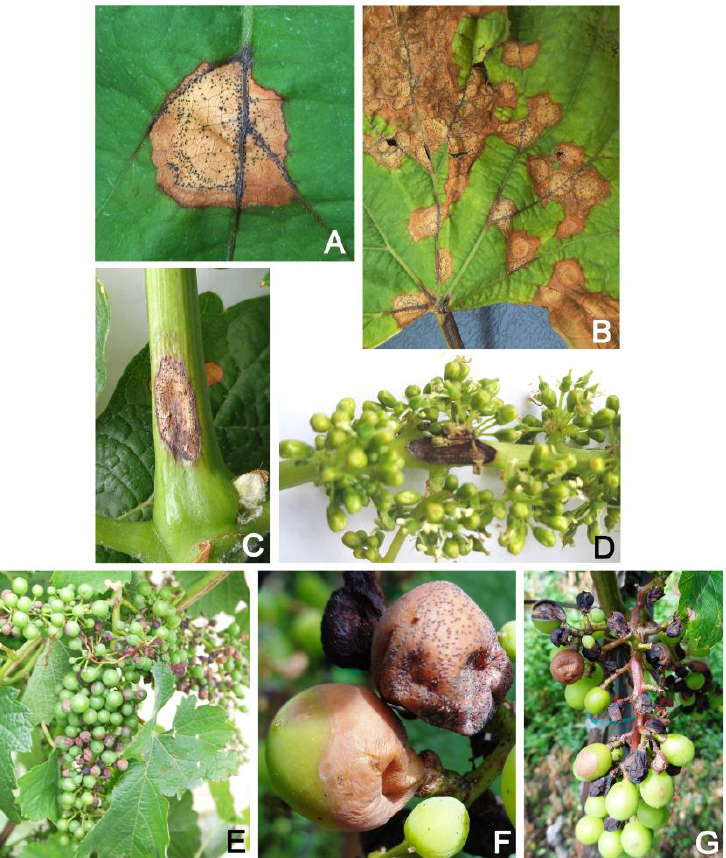
Figure 3. ( A ) Leaf spot with abundant black pycnidia. ( B ) Leaf spots fused together. ( C ) A lesion on torn skin tissue of a shoot. ( D ) Rachis infection ( E ) Partial cluster infection. ( F ) Berries turning brown and mass of pycnidia become apparent on berries. ( G ) Alternating healthy and discoloured diseased berries.